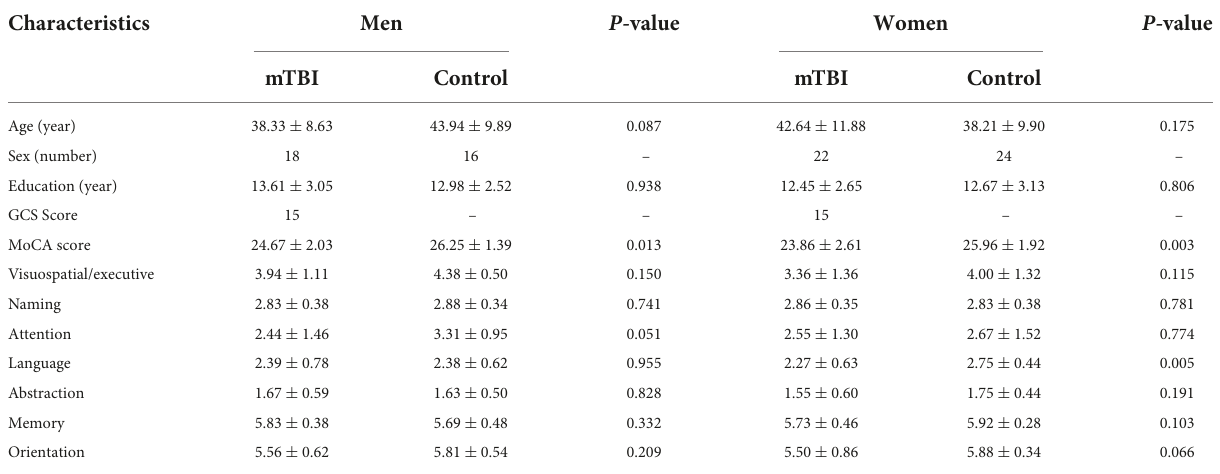
TABLE 3 Demographic characteristics of men and women.